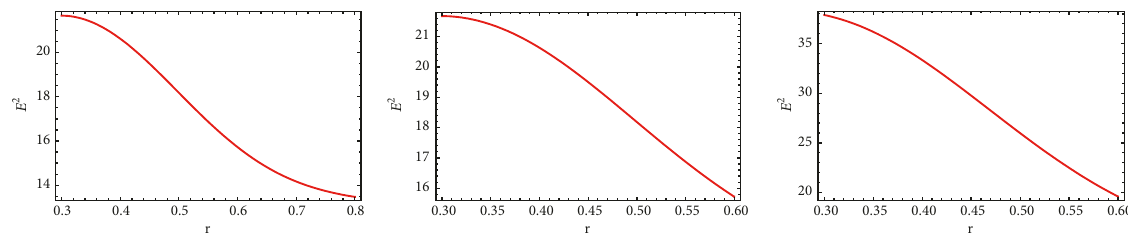
Figure 11: This figure represents the variation of 𝐸 2 versus 𝑟 (km) for the strange star taking 𝛽 = 1 , 𝛽 = 2 , and 𝛽 = 3 .